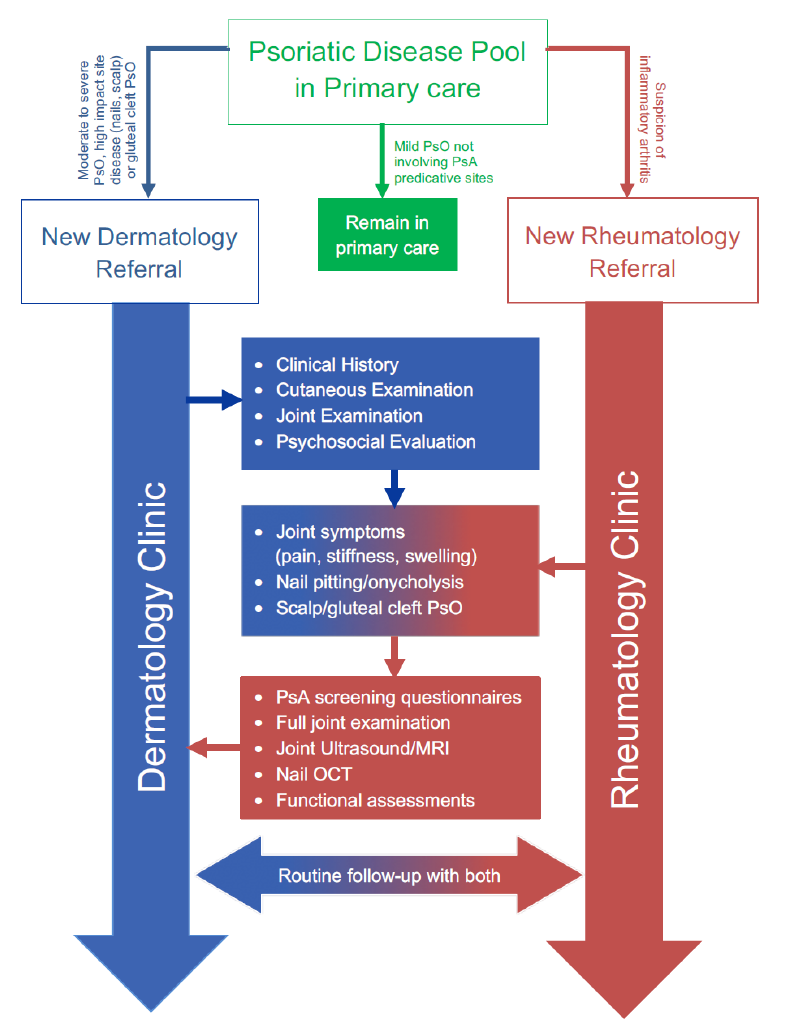
Figure 3. The Leeds Model for shared care in psoriatic disease. MRI: Magnetic Resonance Imaging; OCT: Optical coherence OCT: Optical coherence tomography.